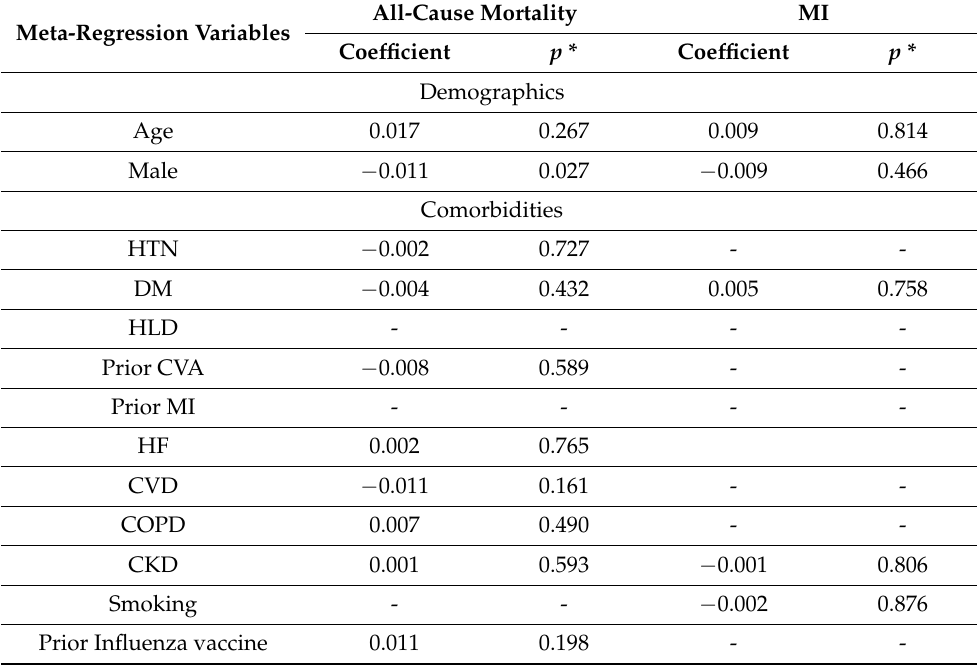
Table 3. Meta-regression of potential effect modifiers for all study outcomes. Meta-Regression